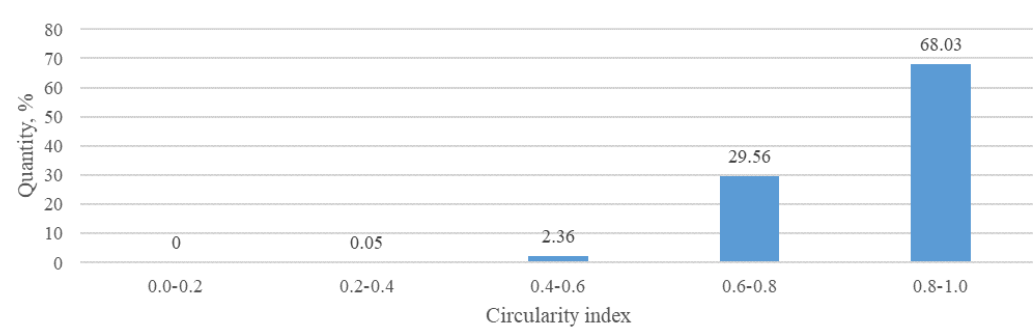
Figure 16. Distribution of pellets according to volume.